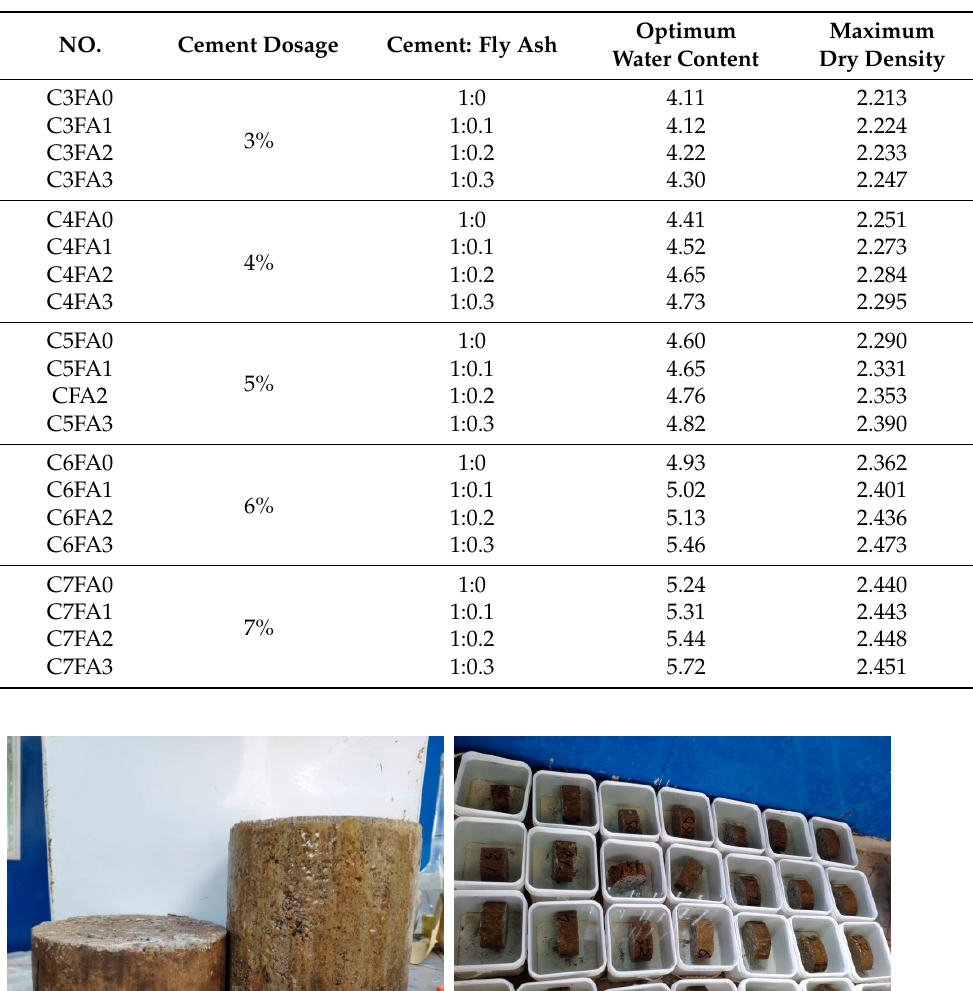
Table 5. Compaction test results of cement-stabilized macadam.